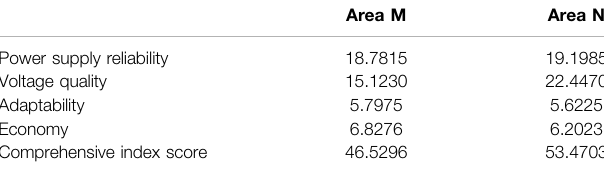
TABLE 5 | Comprehensive score of the two phases of the